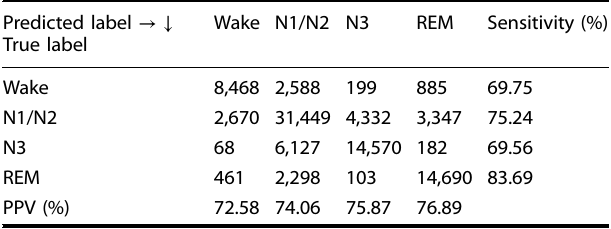
Table 3. Confusion matrix of the combined retrain transfer learning model for sleep stage classi fi